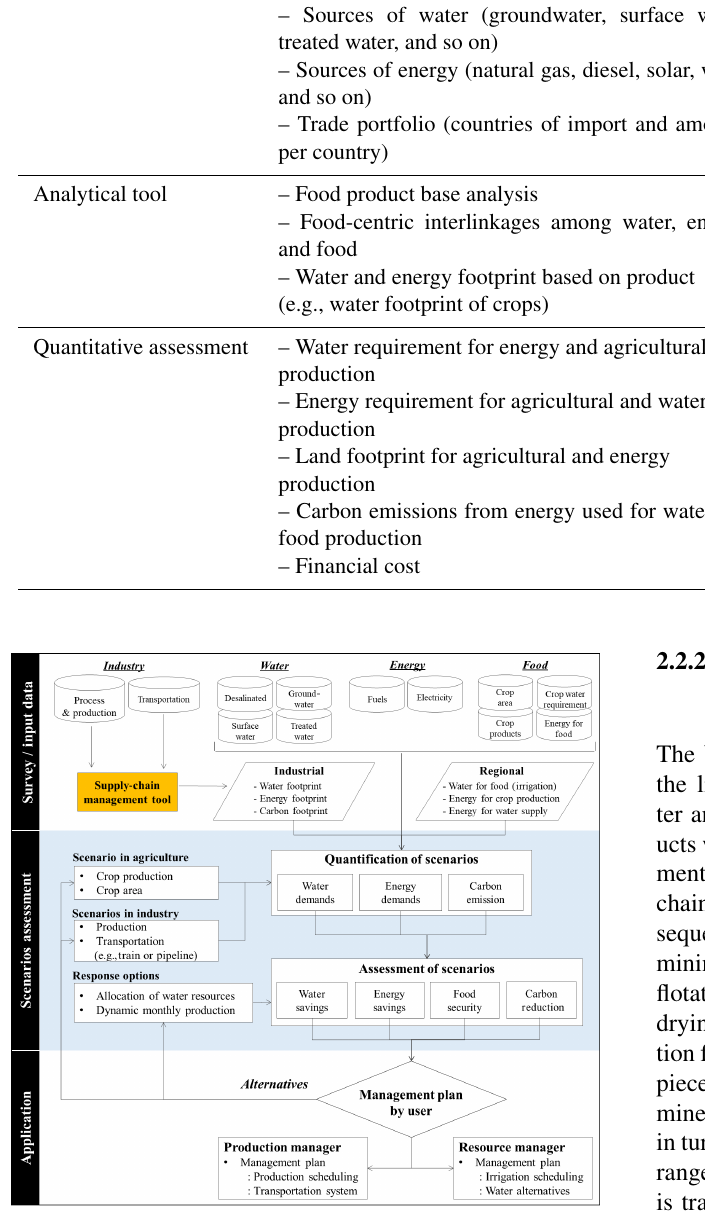
Figure 2. Assessment of holistic impacts of various scenarios relat- ing to the phosphate industry, agriculture, and resource management using WEF-P